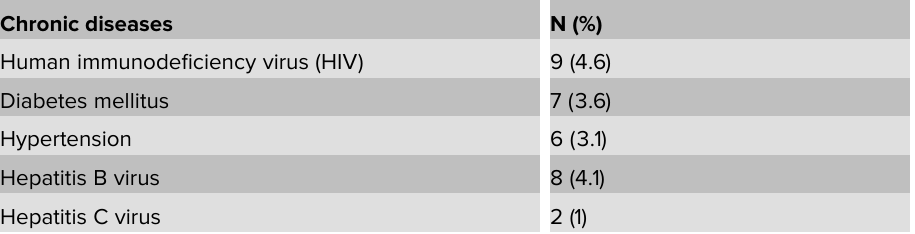
Table 2: Chronic diseases often observed in patients with VL admitted to the TDTH.